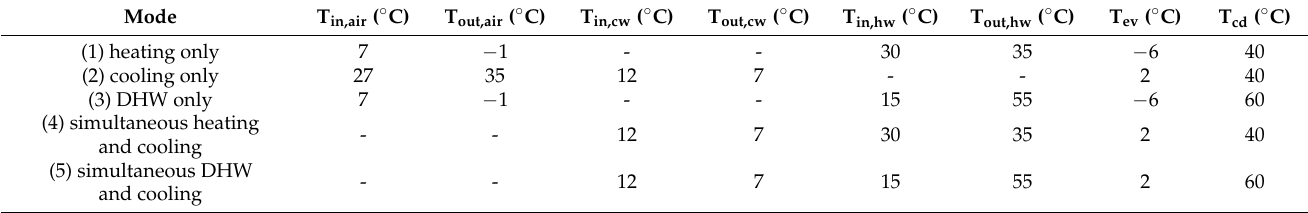
Figure 13. Evolution of COP h&c for R134a and CO 2 cycles depending on evaporating temperature. Table 9. Operating temperatures of simulated